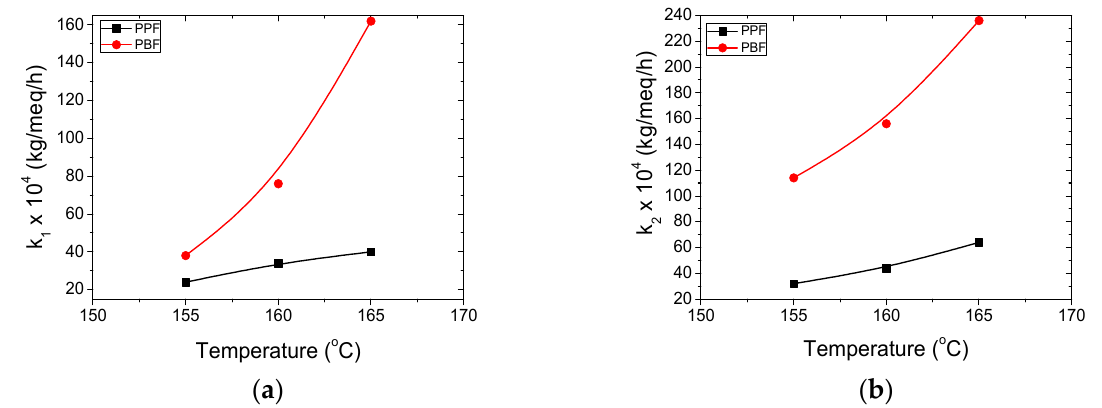
Figure 6. Increase of the estimated kinetic rate constants of ( a ) polycondensation / transesterification (k 1 ) and ( b ) esterification (k 2 ) reactions with temperature of PPF and PBF polyesters.